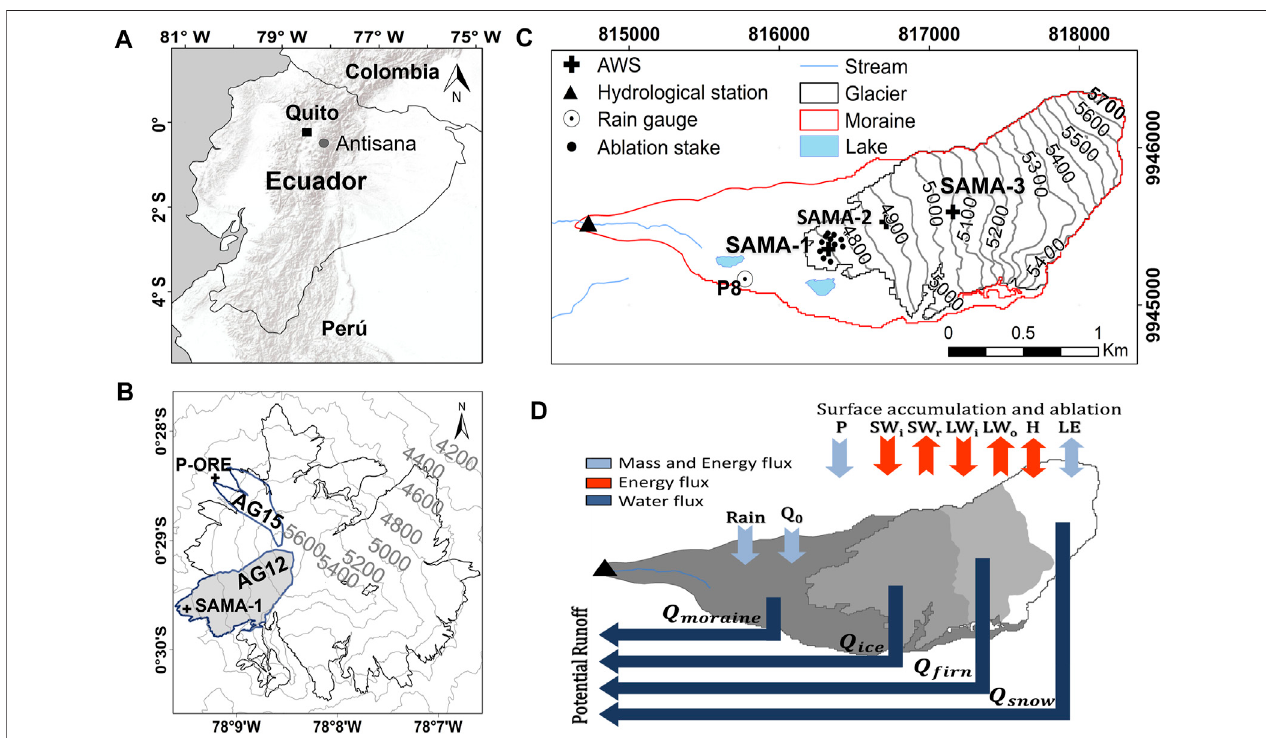
FIGURE 1 | Study area: (A) Location of the Antisana volcano south-eastward of Quito, the capital of Ecuador. (B) Delineation of the studied glaciers in Antisana icecap:TheGlacier15(AG15) onthe northwest fl ankand theGlacier 12(AG12) on thesouthwest shaded in gray.The locationofthe P-ORE and AWS SAMA-1 stations are also shown (black crosses). Cap outline and DEM taken from Basantes-Serrano (2015). (C) Distribution of monitoring network around Glacier 12 catchment. (D) Schema of processes simulated by the coupled glacier-hydrology model illustrating the fl uxes of mass and energy between the atmosphere and land surface implemented over snow, glacier ice, and moraine. Arrows indicate P, precipitation; SWi, incident short-wave radiation; SWr, re fl ected short-wave radiation; LWi, downwelling longwave radiation; LWo, outgoing longwave radiation; H, sensible heat; and LE, latent heat. For moraine zone is also shown the Rain and basal ground fl ow Q 0 .